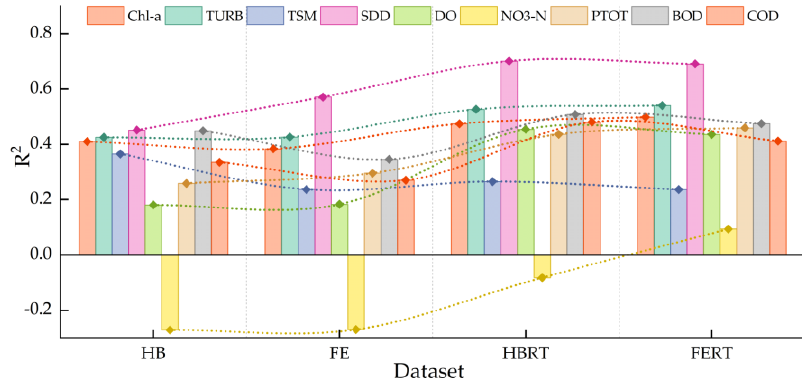
Figure 11. Improvement of temporally and spatially aware models.